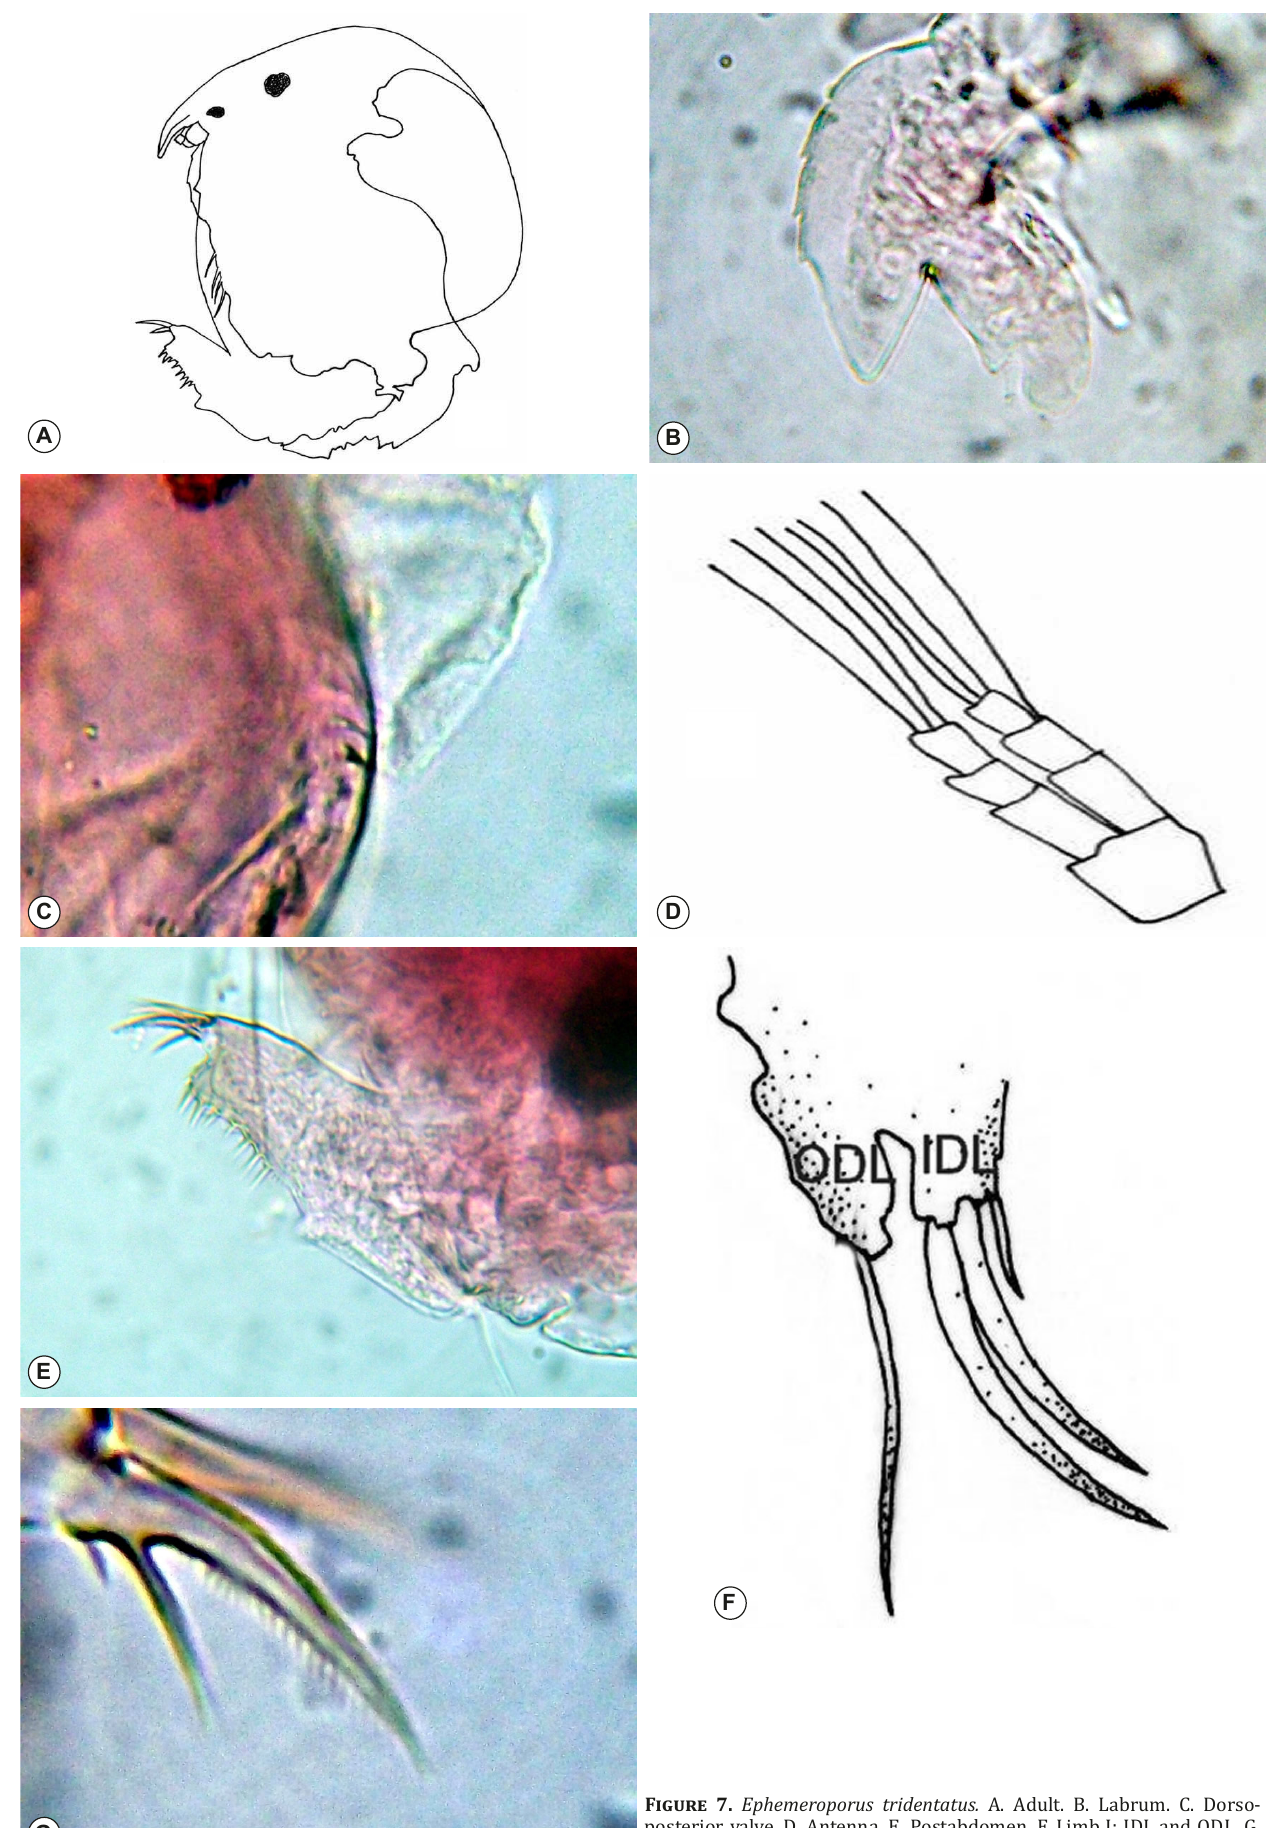
Figure 7. Ephemeroporus